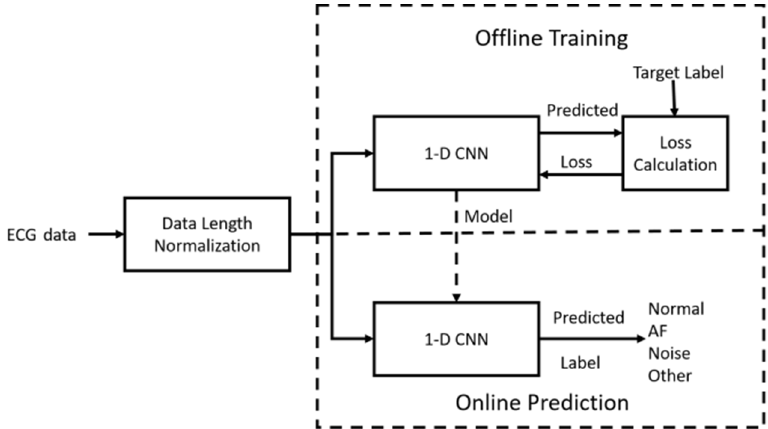
Figure 2. Flowchart of the proposed atrial fibrillation (AF) detection method. ECG: electrocardiogram; CNN: convolutional neural network.